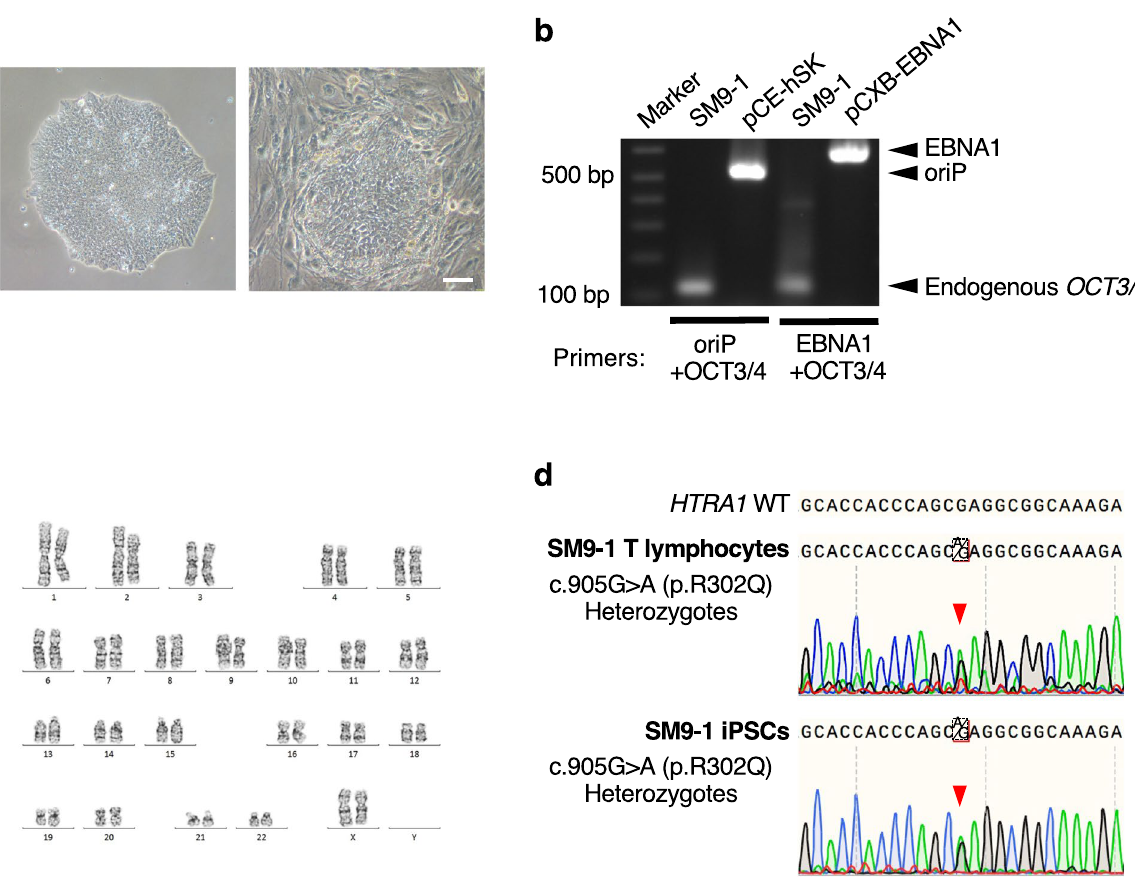
Fig. 2 Characterization of SM9-1 iPSCs. a Morphology of the established iPSC line SM9-1 (left panel: feeder-free condition, right panel: on-feeder condition). Scale bar, 100 μm. b PCR analysis for the detection of remaining oriP/EBNA1-based reprogramming vectors. c Karyotype analysis